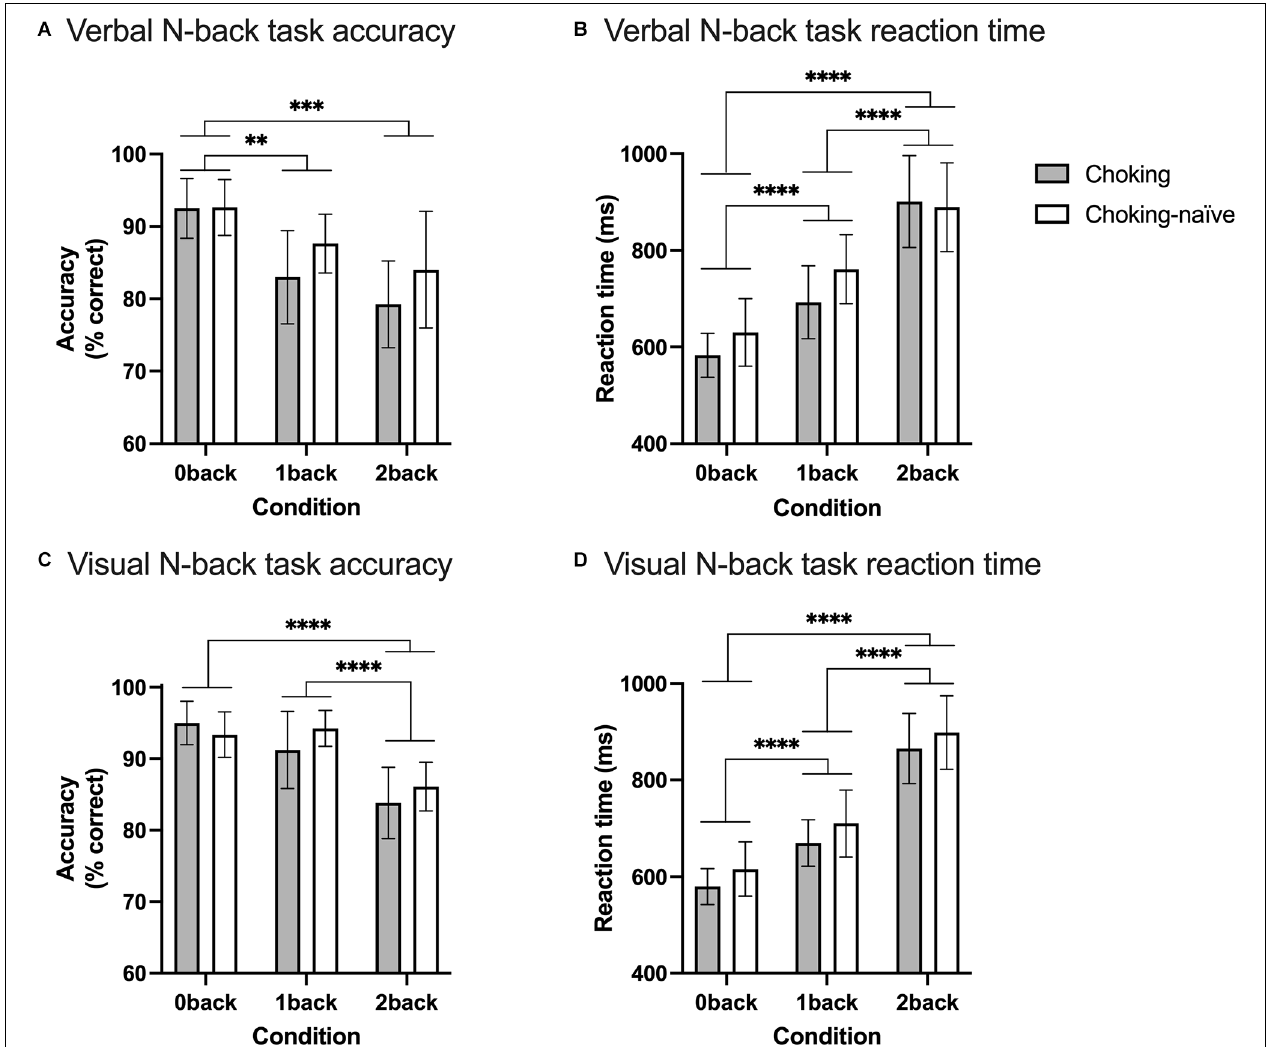
FIGURE 2 | Working memory task performance, in terms of accuracy and reaction time. Accuracy (A) and reaction time (B) for the verbal N-back working memory task and accuracy (C) and reaction time (D) for the visual N-back working memory task are shown using bars and error bars to depict means and 95% confidence intervals, respectively. The significance of depicted pairwise comparisons is represented with asterisks as follows: * p < 0.05, ** p < 0.01, *** p < 0.001, **** p <